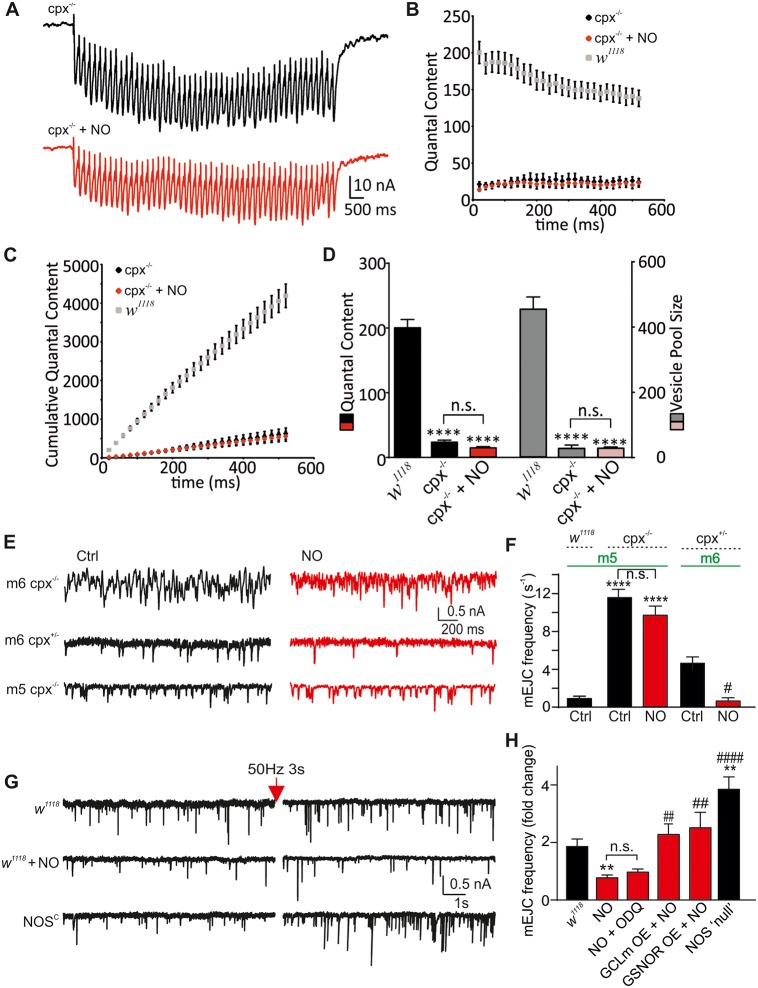
Nitrergic effects on evoked and spontaneous release require cpx.(A) Raw eEJC recordings of a 50-Hz train, 500 ms in cpx-/- larvae (±NO). (B) Mean QC for genotypes indicated, showing the lack of NO effects in cpx-/- larvae (w1118 Ctrl in grey from Fig 2). (C) Cumulative QC for the same conditions as in (B). (D) Mean QC and vesicle pool sizes for the genotypes indicated (w1118 Ctrl data from Figs 1 and 2, ****p < 0.0001 versus w1118 Ctrl). (E) mEJCs recordings from m6 and m5 in cpx-/- and cpx+/- ± NO. (F) Mean mEJC frequencies for conditions and genotypes indicated (****p < 0.0001 versus m5 w1118 Ctrl, #p < 0.05 versus m6 cpx+/- Ctrl). (G) Raw traces of mEJC recordings before (left) and after (right) high frequency stimulation in w1118 (±NO) and NOSC larvae. (H) Average fold change of mEJC frequency during 50 s after stimulation compared to baseline frequency before stimulation for conditions and genotypes indicated (NOS “null” comprised of data from NOSC and NOSΔ15). NO treatment (40 min) suppresses increases in frequency, NOS “null” potentiates relative increases and enhanced denitrosylation (GCLm and GSNOR OE) prevents NO-induced suppression (*p < 0.05, **p < 0.01 versus Ctrl, ##p < 0.01, ####p < 0.001 versus NO). The raw data can be found in S5 Data. Data denote mean ± SEM in all graphs, ANOVA with post hoc Tukey-Kramer. Ctrl, control; cpx, complexin; eEJC, evoked EJC; EJC, excitatory junction current; GCLm, glutamate-cysteine ligase catalytic subunit M; GSNOR, S-nitrosoglutathione reductase; mEJC, miniature EJC; m5, muscle 5; m6, muscle 6; NO, nitric oxide; OE, overexpression; QC, quantal content.